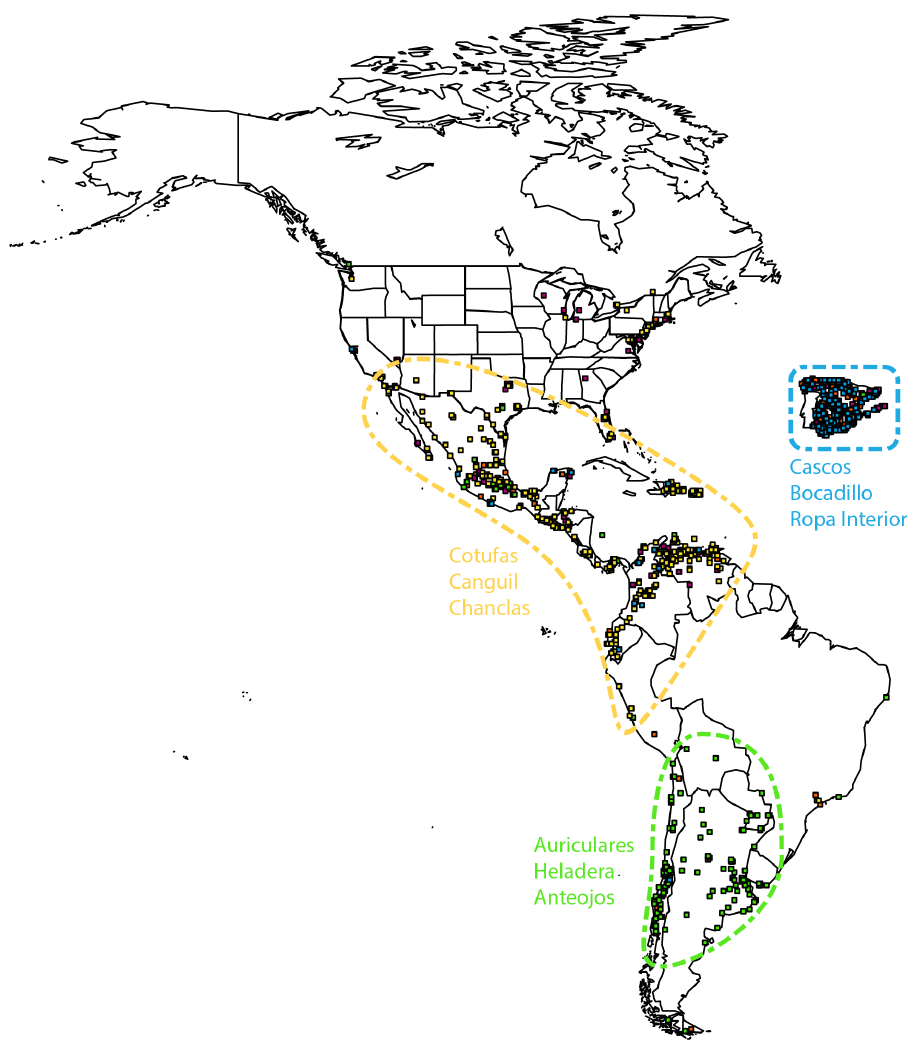
Figure 5. Characterization of major cluster b . Geographical representation of regional dialects. For visualization purposes we increased the size of each cell. Three well separated regions are indicated with dashed lines along with the top 3 dominant words characteristic of that